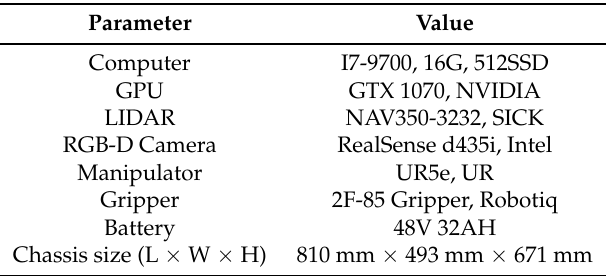
Table 1. The hardware parameters of the mobile manipulator.